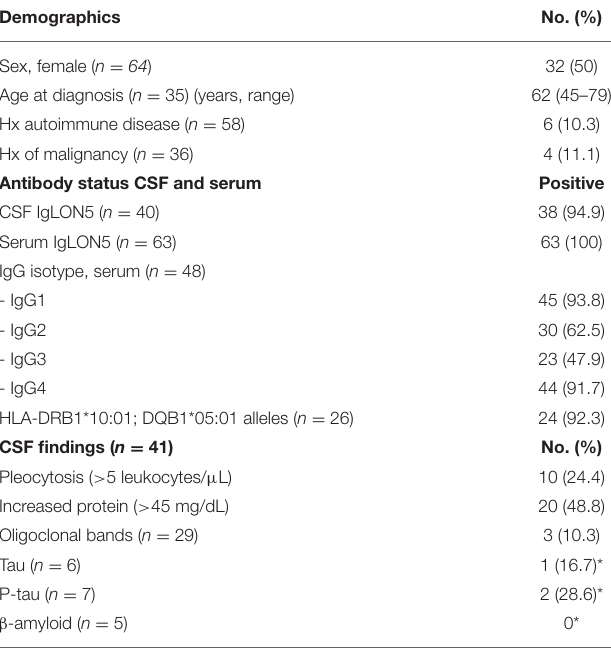
TABLE 1 | Demographics, antibody status, and CSF findings. Demographics